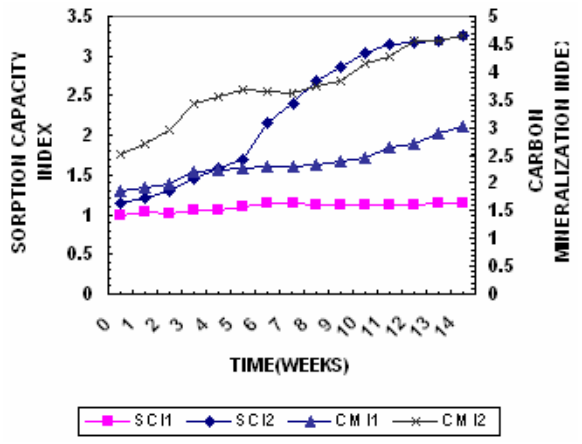
Fig 5: Variation of Scorpion Capacity Index and Compost Mineralization Index during composting.